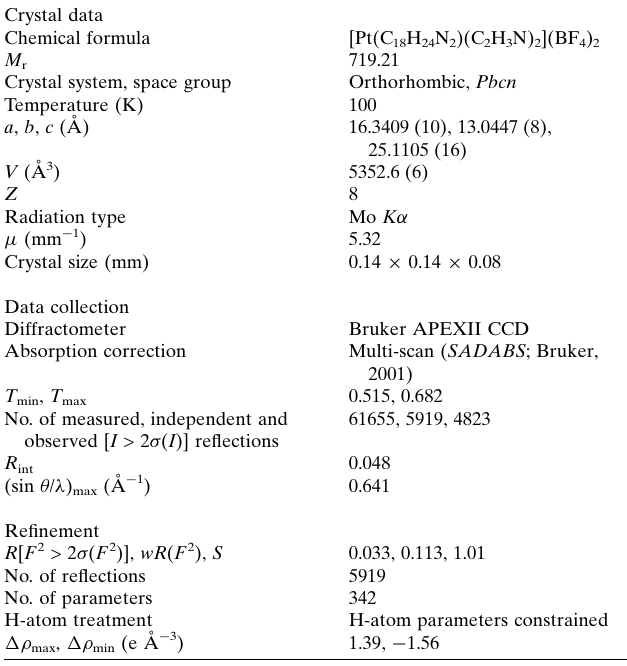
Table 2 Experimental details. Crystal data Chemical